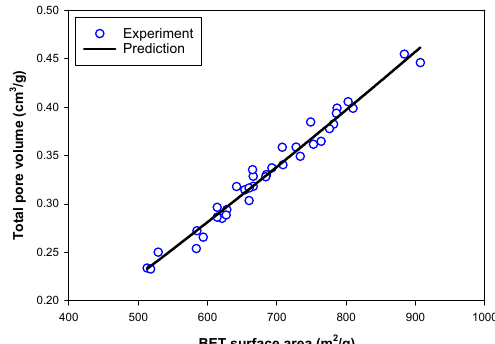
Figure 14. The correlation between total pore volume ( V tot ) and BET surface area. The black solid line is predicted from Equation (11), while the blue circles are the experimental data .